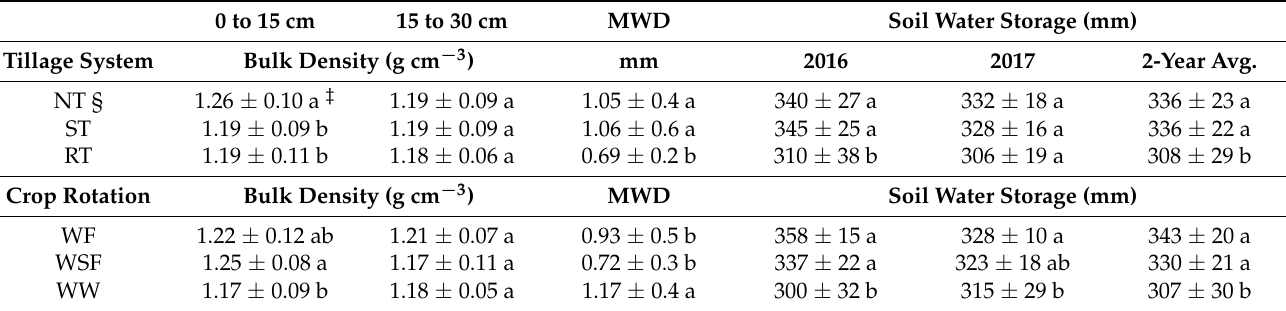
Figure 1. Tillage and crop rotation effects on weed count one month after tillage in 2016 and 2017. Means followed by the same lower-case letter(s) within a crop rotation are not significantly different using the least squares means (LSMEANS) and adjusted Tukey multiple comparison procedure ( p > 0.05). WF = Wheat-fallow; WSF = wheat-sorghum-fallow; WW = Wheat-wheat. Table 2. Soil bulk density in the 0 to 15 and 15 to 30 cm depth, mean weight diameter (MWD) of soil aggregates from the 0 to 5 cm depth and soil water content from the 0 to 150 cm depth at wheat planting as affected by tillage and crop rotation